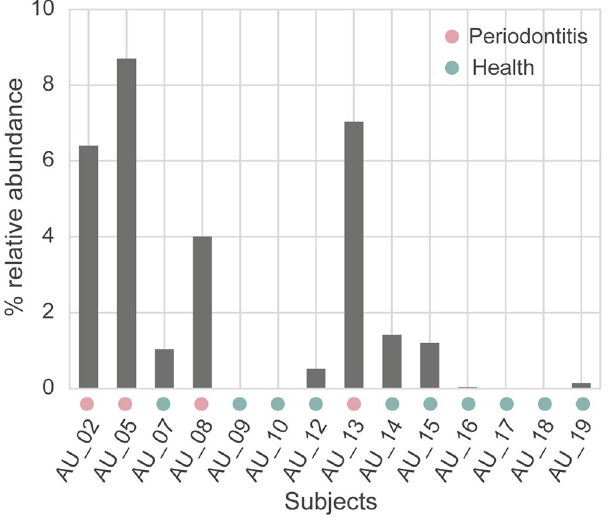
Figure 6. Abundant En . gingivalis in periodontitis. Total reads (without rRNA removal using SortMeRNA) from each sample were mapped against the 18S rRNA gene of En . gingivalis .